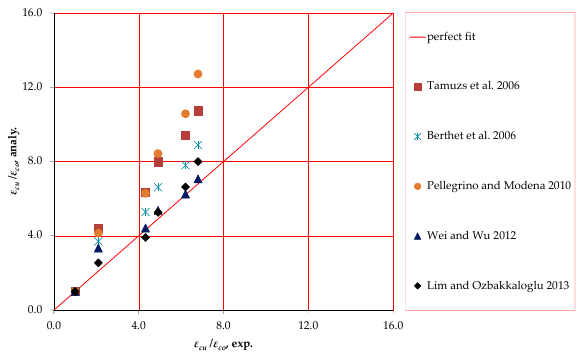
Figure 5. Axial strength predictions of investigated models.